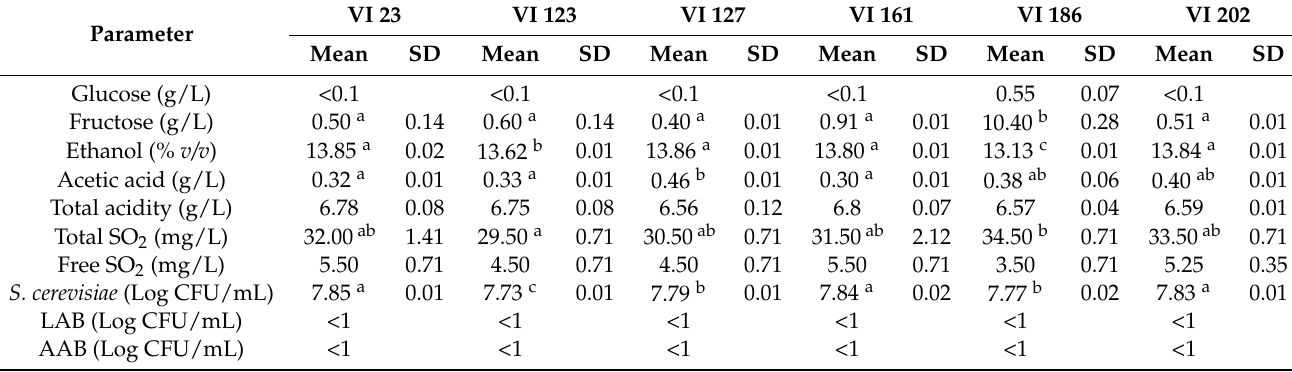
Table 2. Chemical and microbiological analyses performed at the end of the alcoholic fermentations carried out by the six selected indigenous S. cerevisiae strains (LAB = lactic acid bacteria, AAB = acetic acid bacteria). Values with different superscript letters (a, b, c) within a row indicate significant different concentrations between strains (ANOVA, p < 0.05). Parameter